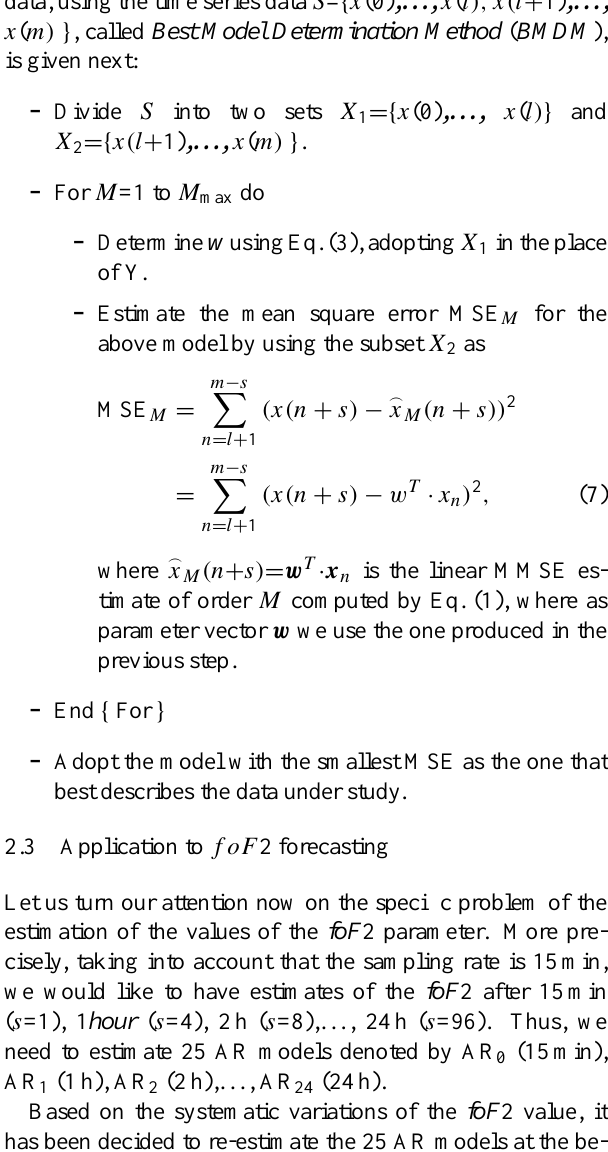
Fig. 1. At each epoch AR models are re-estimated based on the measurements of the previous